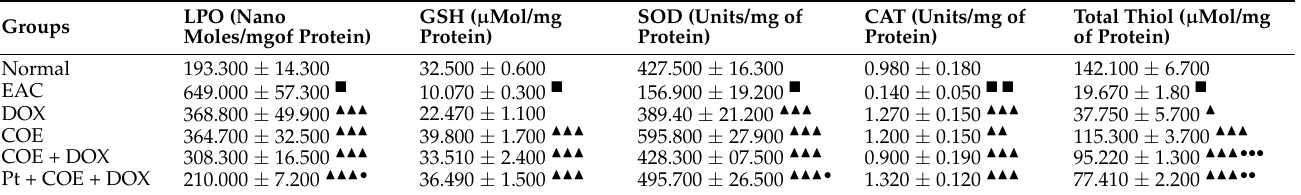
Table 8. Effect of COE on enzymatic and nonenzymatic antioxidant biomarkers in the liver homogenate.